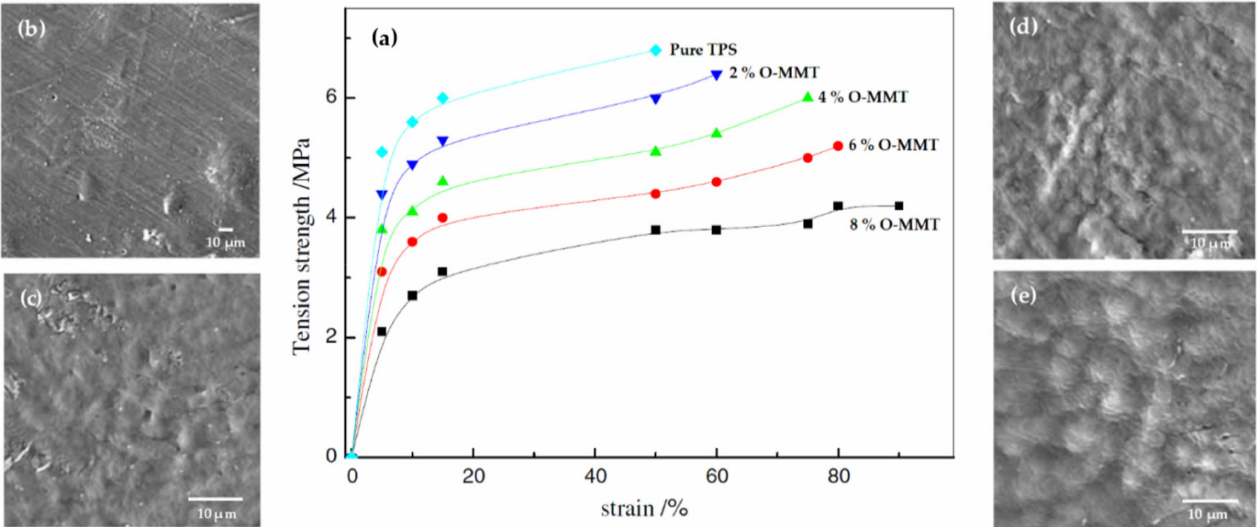
Figure 24. ( a ) Tension strength versus strain for neat TPS and the TPS/O-MMT nanocomposites indicated. SEM images of ( b ) 2% O-MMT, ( c ) 4% O-MMT, ( d ) 6% O-MMT, ( e ) 8% O-MMT. Reproduced with permission from Polym. Environ. , 17 , Ren et al., Study on biodegradable starch/OMMT nanocomposites for packaging applications, 203–207, 2009